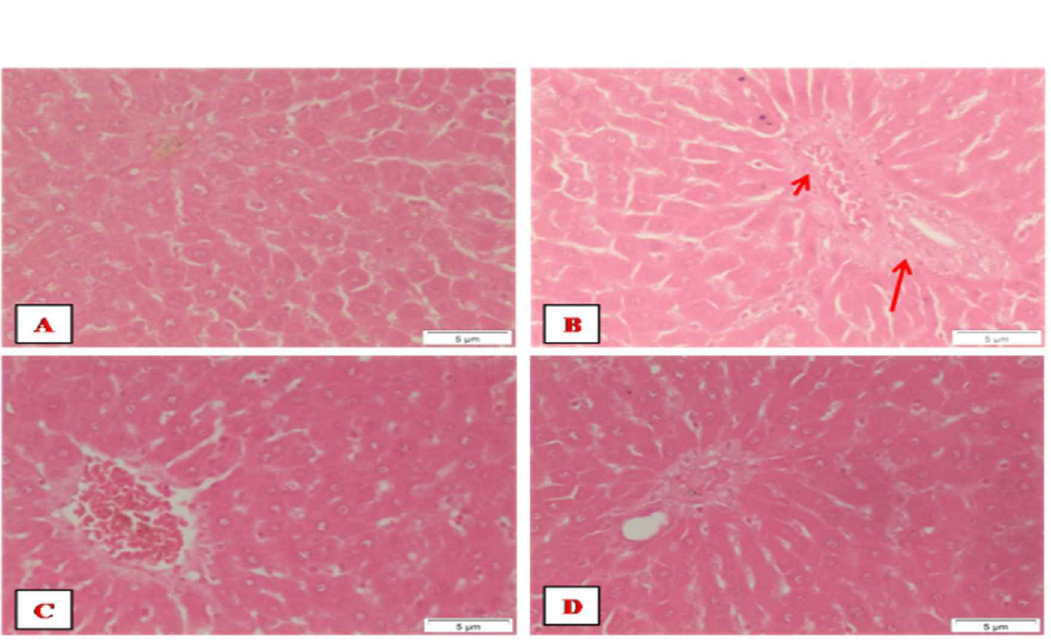
Fig 6. Photographs of liver sections stained with H & E. (A and B) Dox+EA treated rats showing the ordinary structure of the hepatic lobule and congested portal area (arrows) that were associated with moderate inflammatory infiltration (arrowheads). (C and D) Ellagic acid-treated rats showing the ordinary structure of the hepatic lobule and portal area, respectively.